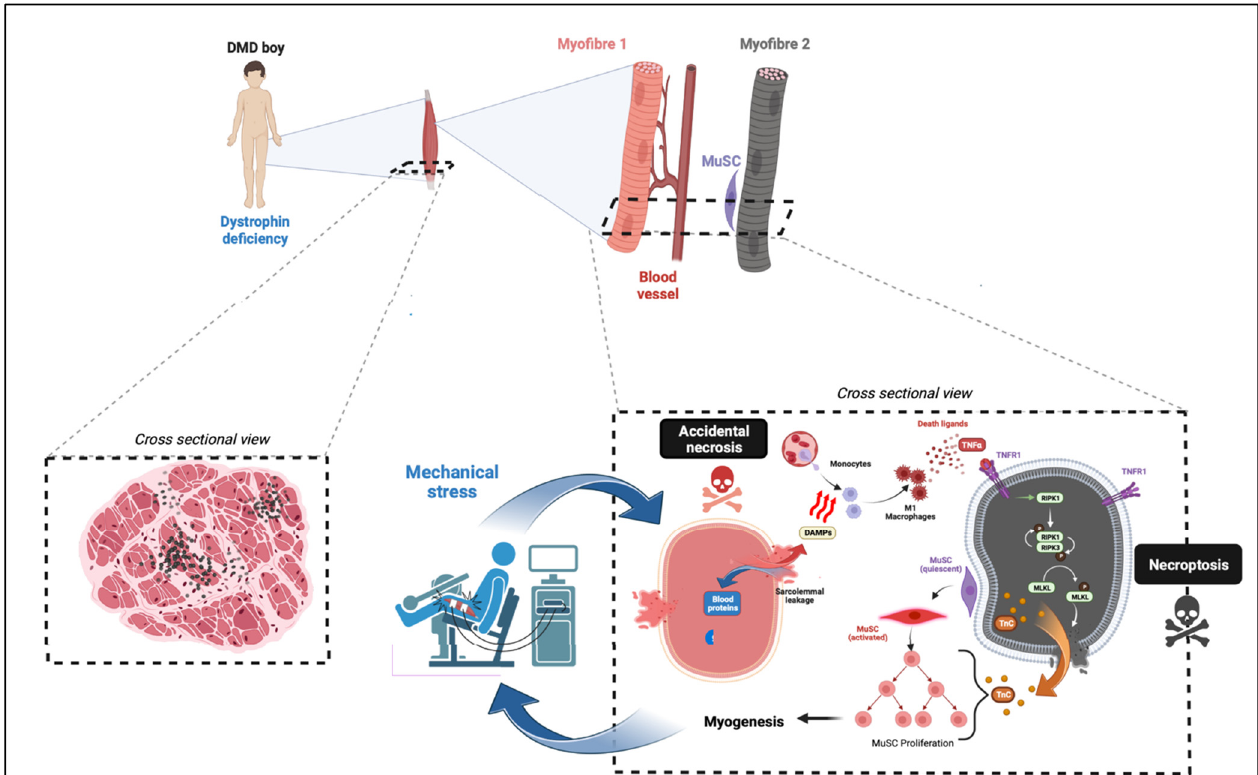
Figure 2. Model for necroptosis involvement in Duchenne muscular dystrophy. Limb muscles from DMD boys are affected by chronic necrosis affecting myofibres. Genuine milestone of cell death events is likely to come from exercised-induced breaks into sarcolemma missing dystrophin (necrosis by accidental process affecting Myofibre 1, pink colour). A direct consequence of this accidental necrosis is the activation of necroinflammation via the release of DAMPs, and the classical activation of infiltrated macrophages. M1 macrophages secrete pro-inflammatory molecules, including death ligands such as TNF α binding to their DR. TNF α binding to TNFR1 of myofibres and recruits RIPK1. The kinase activity of RIPK1 is required to recruit RIPK3 into the necrosome complex. RIPK3- dependent phosphorylation of MLKL promotes the recruitment of p-MLKL to the sarcolemma, the formation of pores, and compromises the integrity of the plasma membrane of myofibres (necrosis by necroptotic pathway). Myofibre necroptosis is associated with tenascine C (TnC) release, which supports MuSC proliferation and early